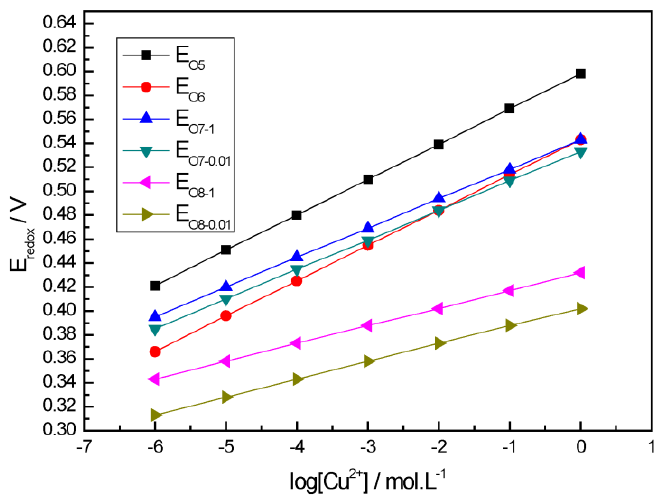
Figure 7. Potentials for bornite oxidization through different routes.